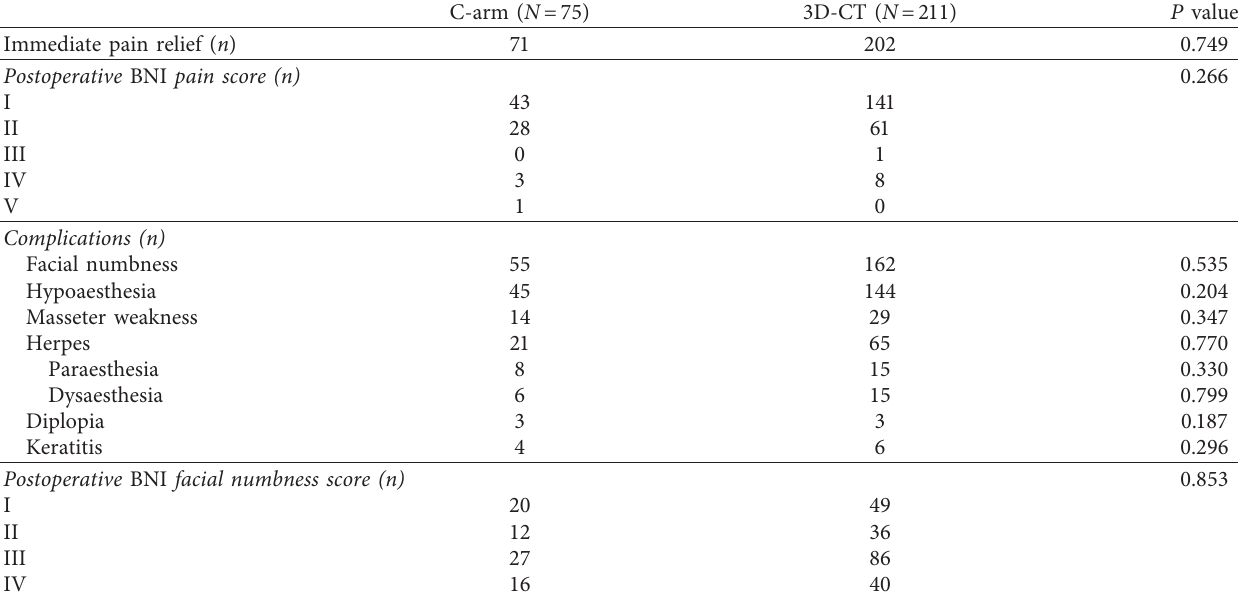
Table 2: Summary of immediate effectiveness and postoperative